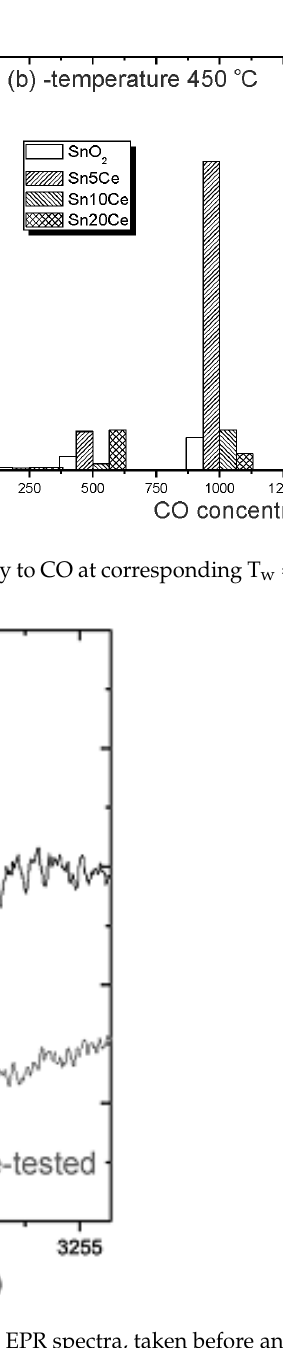
Figure 10. 5% SnO 2 -CeO 2 sensitive powder EPR spectra, taken before and after sensing experiments, from Ref. [40].